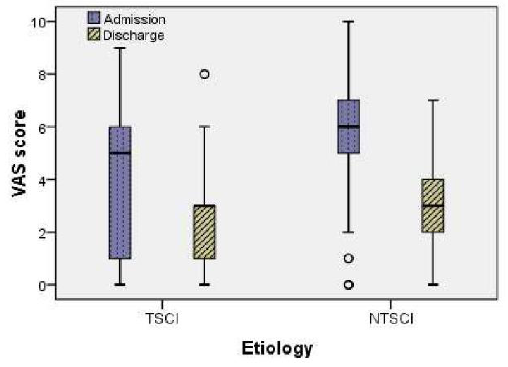
Figure 3. The distribution of VAS scores across categories of etiology (T-SCI/NT-SCI).